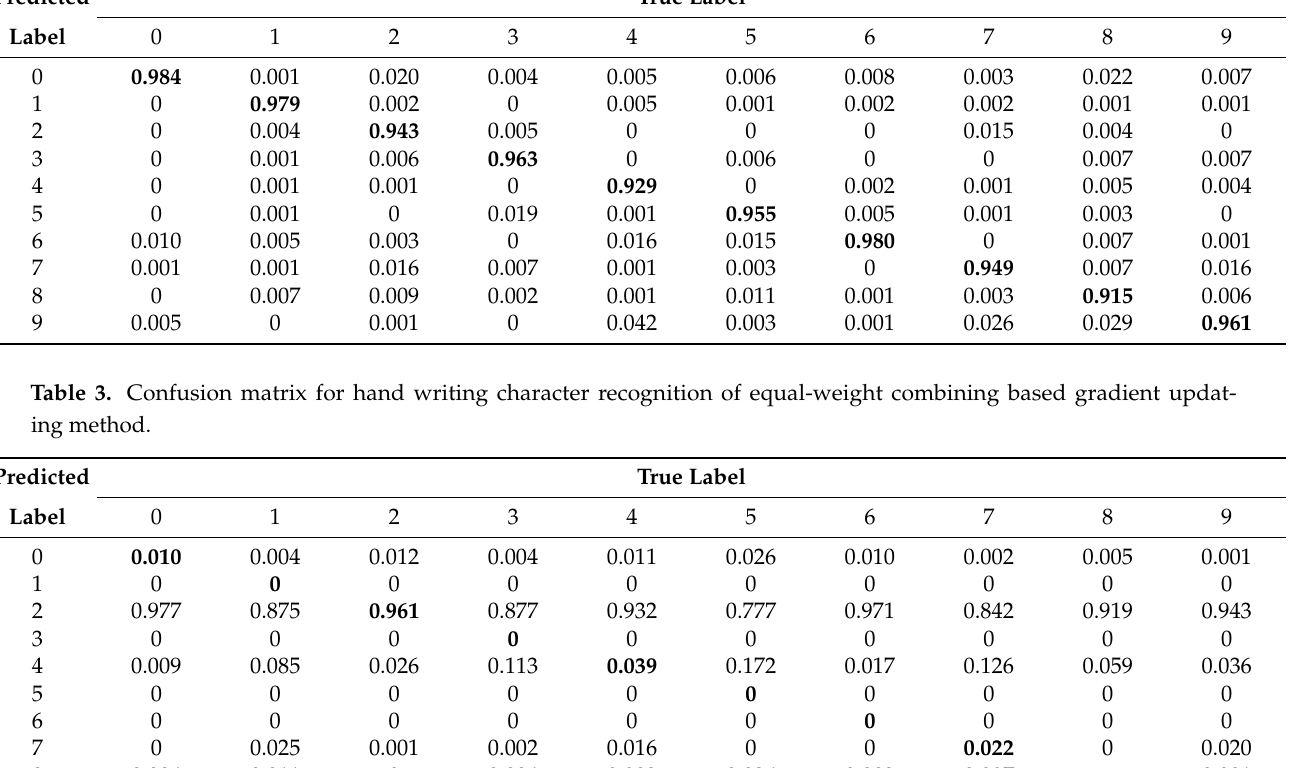
Table 2. Confusion matrix for hand writing character recognition of the proposed gradient updating method. Predicted